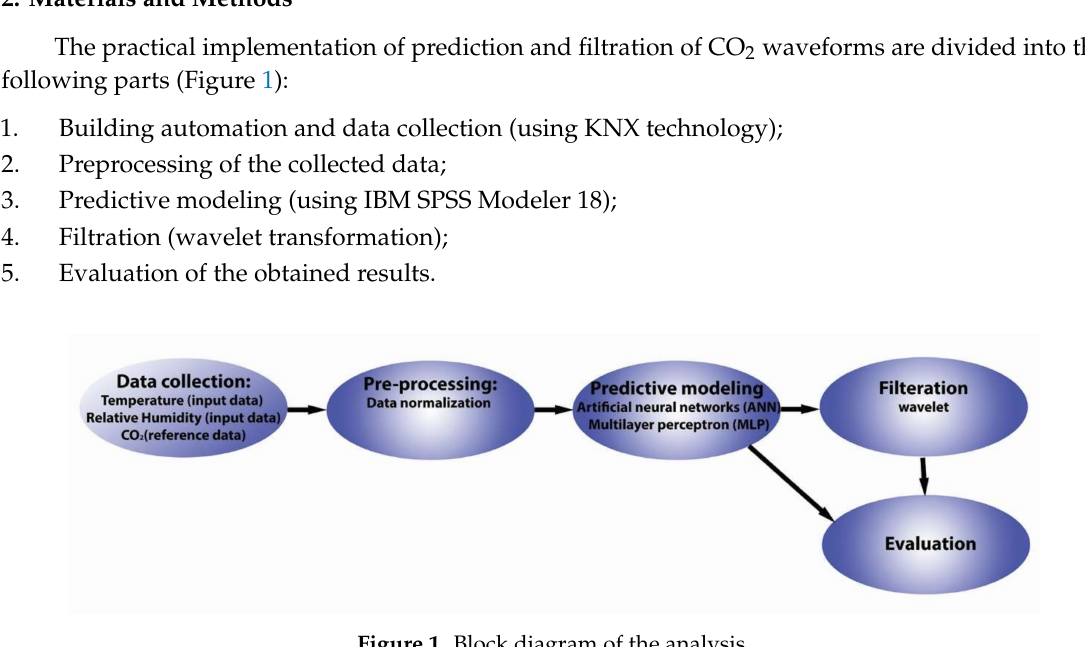
Figure 1. Block diagram of the